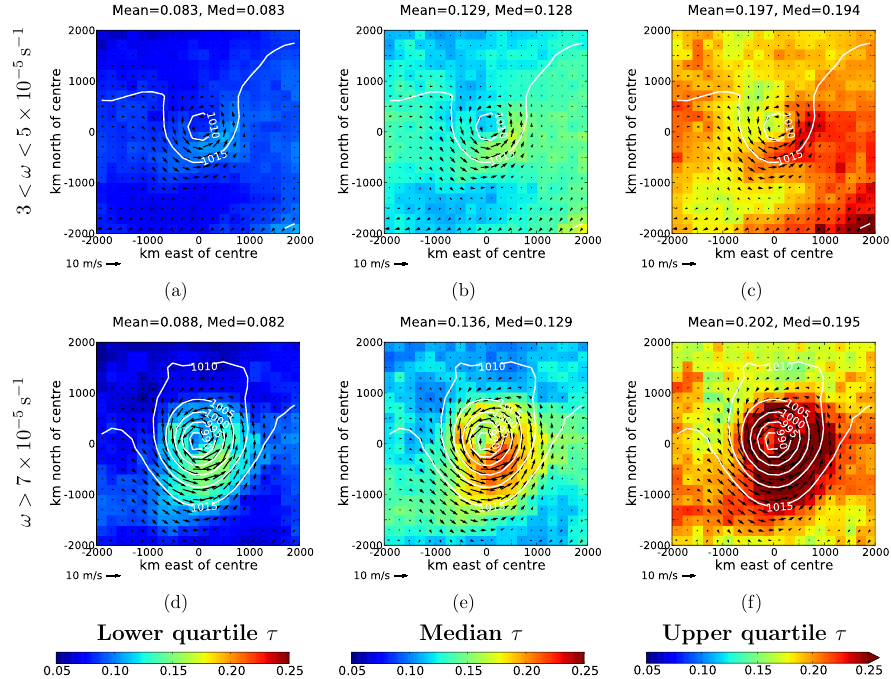
Figure 1: Fig. 1. Storm-centric (a, d) lower quartile, (b, e) median and (c, f) upper quartile composites of Aqua-MODIS aerosol optical depth ( τ ) for two 850hPa relative vorticity ( ω ) ranges over the North Atlantic ocean. Median composites of ERA-Interim mean sea level pressure ( p 0 ; white contours) and wind vectors (black arrows) are over-plotted. The wind vector scale is provided at the bottom left-hand edge of each composite. Positive meridional displacements are poleward of the storm centre. The data cover